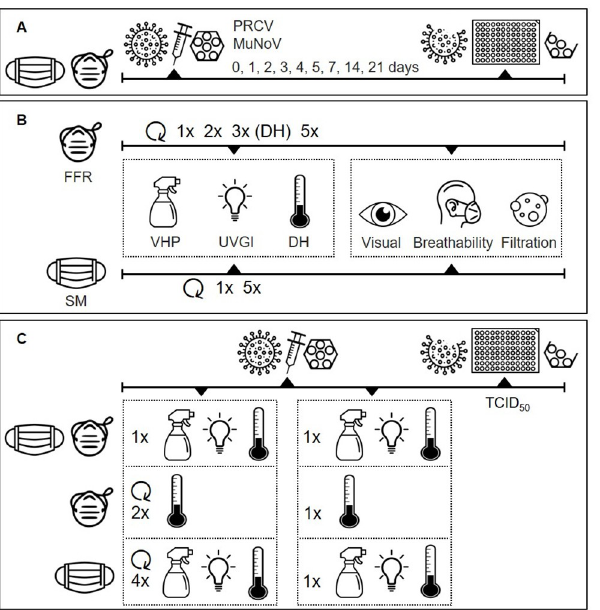
Fig 1. Experimental set-up of filtering facepiece respirator (FFR) and surgical mask (SM) decontamination assays. (A) Natural virus degradation over time. (B) Integrity testing after multiple-cycle vaporised hydrogen peroxide (VHP), ultraviolet germicidal irradiation (UVGI), and dry heat (DH) decontamination. (C) Multiple-cycle decontamination of porcine respiratory coronavirus (PRCV)- and murine norovirus (MuNoV)- inoculated